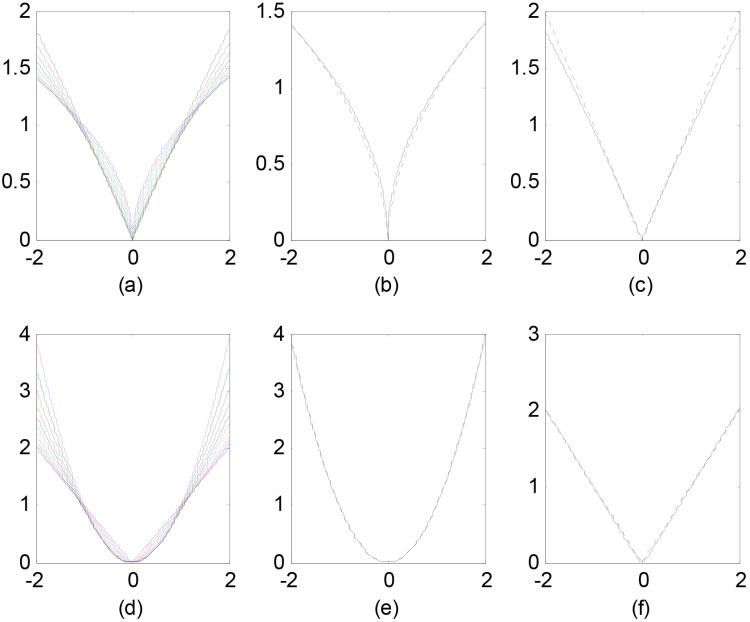
The complex harmonic regularization.(a) the curves represent m(⋅) at different parameter a values; (b) the solid curve represents m(⋅) at the parameter a = 0.99, and the dashed curve is the ℓ1/2 regularization; (c) the solid curve represents m(⋅) at the parameter a = 0.01, and the dashed curve is the ℓ1 regularization; (d) the curves represent n(⋅) at different parameter b values; (e) the solid curve represents n(⋅) at the parameter b = 0.01, and the dashed curve is the ℓ2 regularization; (f) the solid curve represents n(⋅) at the parameter b = 0.99, and the dashed curve is the ℓ1 regularization.